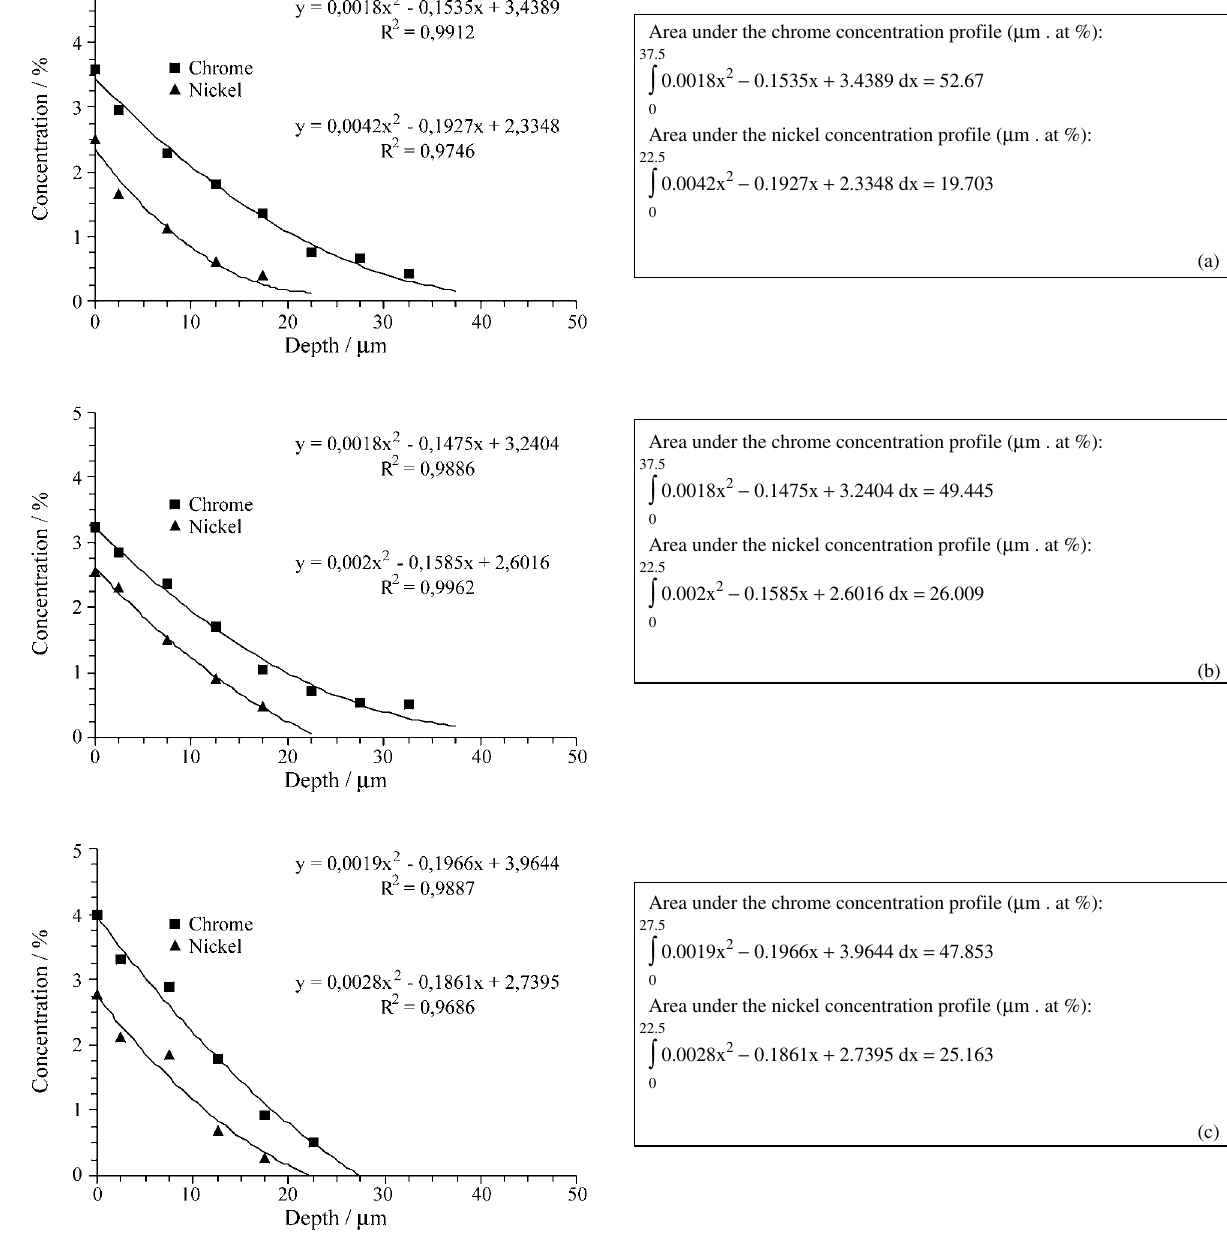
Figure 4. Concentration profiles of Cr and Ni, with the corresponding fitted equations and calculated areas indicated, for iron samples processed with radial spacings between cathodes of: a) 3.2 m; b) 5.8 mm and c) 9.2